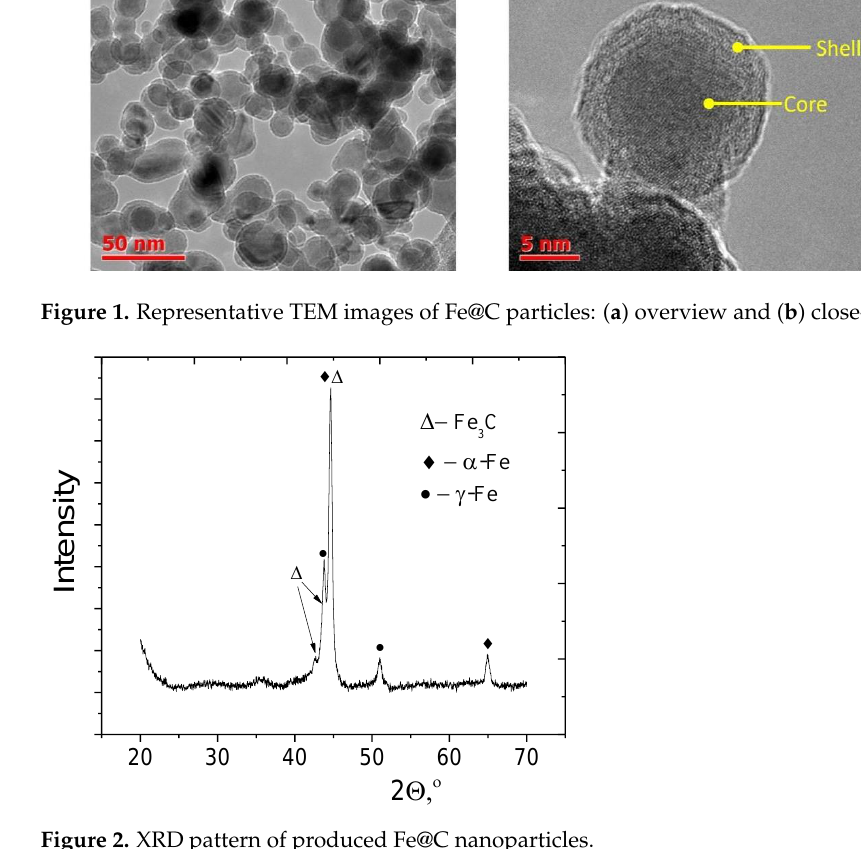
Figure 2. XRD pattern of produced Fe@C nanoparticles.